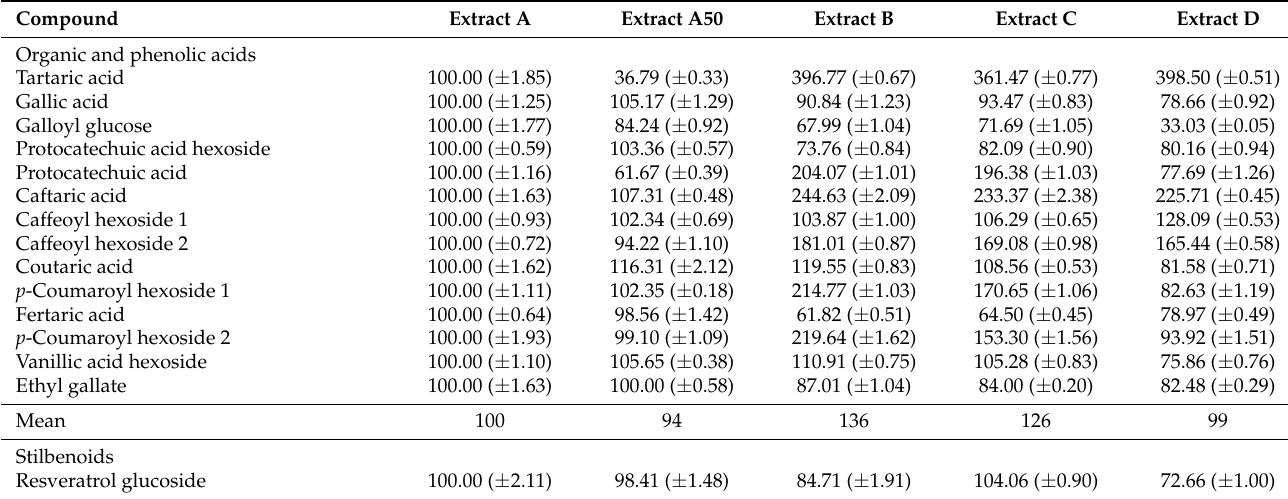
Table 14. Relative percentage (mean ± SD) of each organic and phenolic acid in extracts A50 B, C and D calculated in respect to the content determined in extract A and set as 100%. The relative percentages were calculated by measuring the areas of the peaks reconstituted by setting the [M-H] − as filter ions.